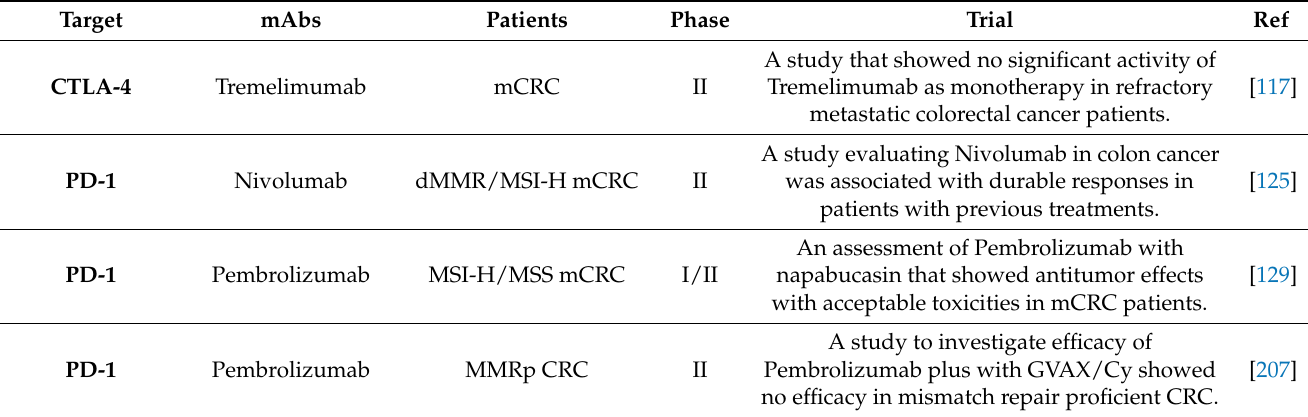
Table 1. Clinical trials in colorectal cancer